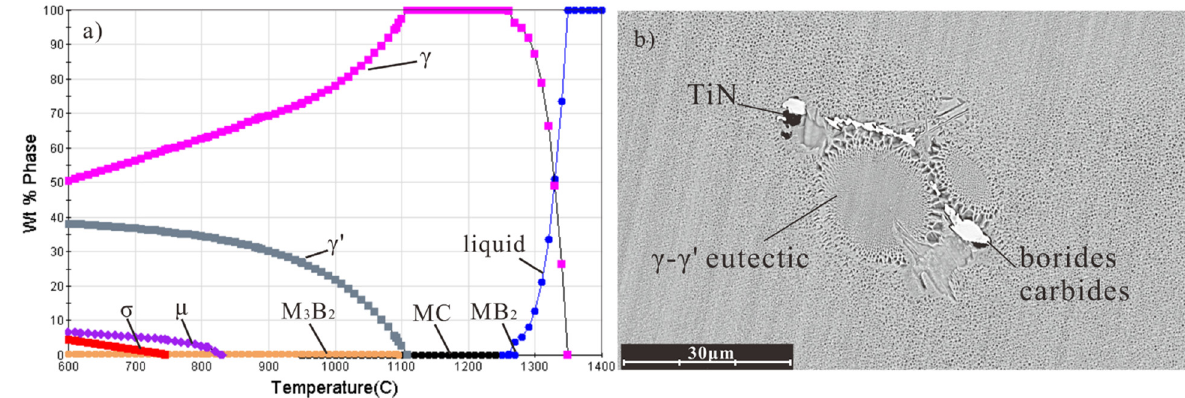
Figure 4: ( a ) Phase diagram of René 65 at equilibrium and ( b ) typical interdendritic phases in as - cast René